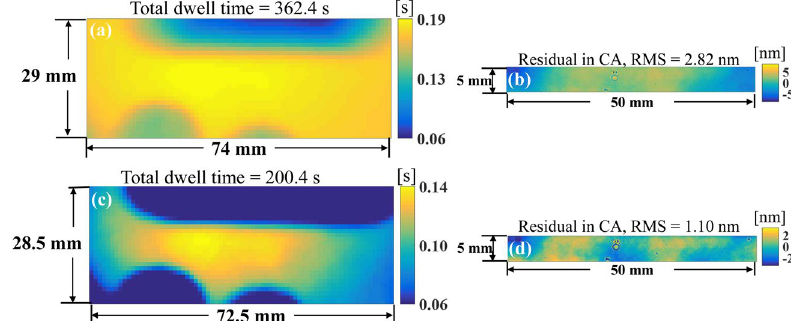
Figure 9. Dwell time maps ( a , c ) and estimated residual maps in the CA ( b , d ) calculated using the RIFTA without the two-level iterative scheme ( a , b ) and with the two-level iterative scheme ( c , d